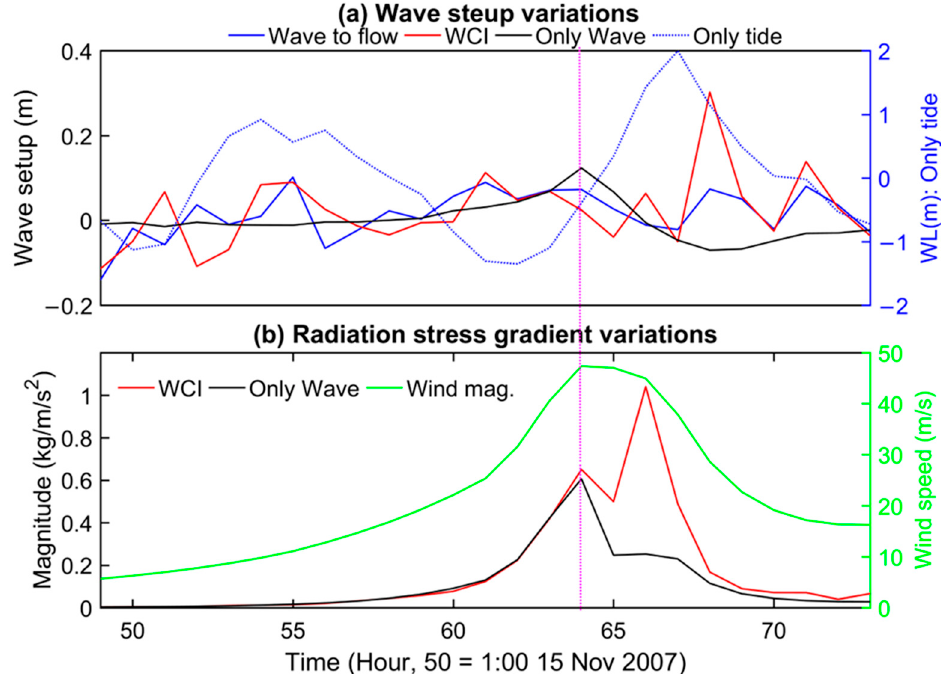
Figure 7. Model simulated wave setups ( a ) along with tidal water level variations for Wave to flow (Run6), WCI (Run1), OWC (Run7 in Table 2), and ( b ) radiation stress gradient magnitude variations with wind speed for WCI (Run1) and Wave Only (Run2 in Table 2) at Khepupara. The purple dotted line indicates the landfall time. Model tidal water level variations are from